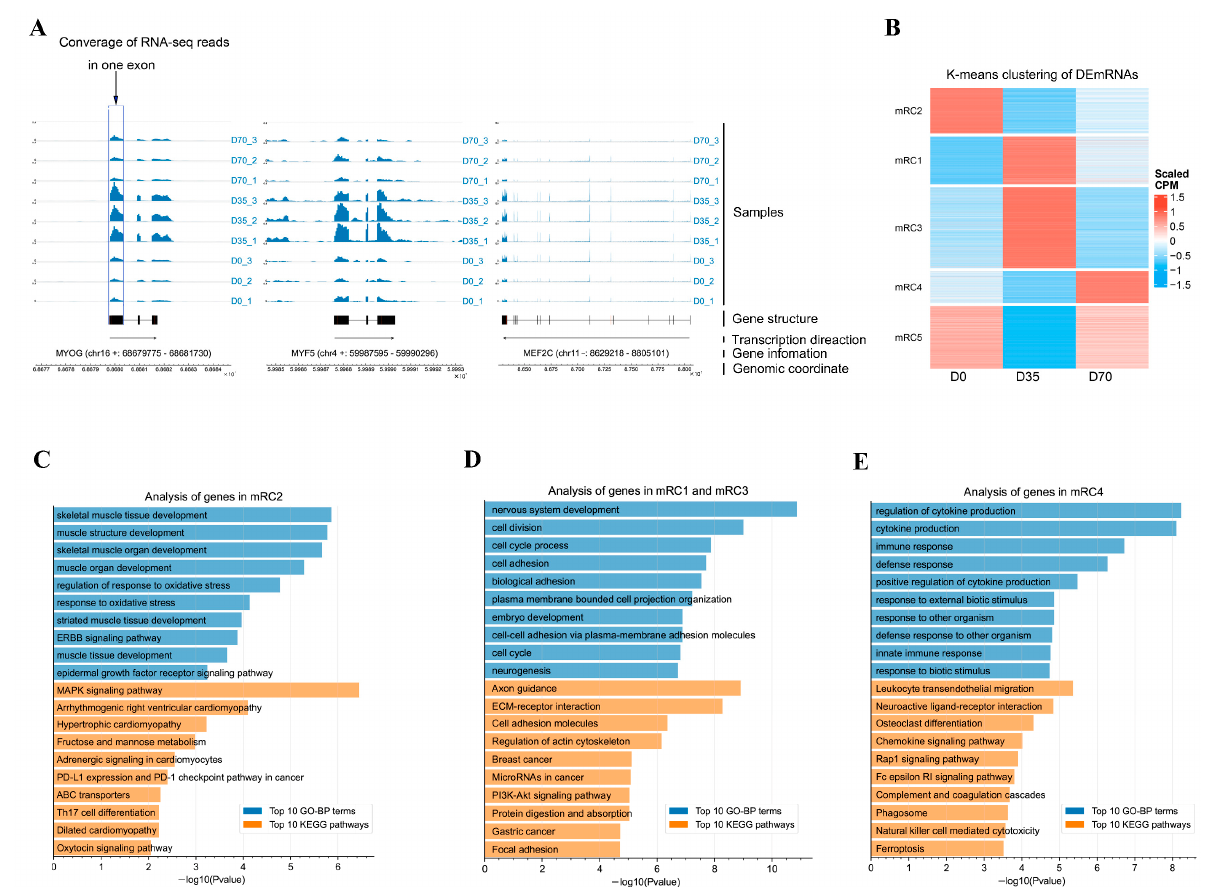
Figure 1. Dynamics of mRNA expression during development of skeletal muscle tissues at three growth stages in rabbits. ( A ) The RNA-seq tracks of all samples for the key genes ( MYOG , MYF5 , and MEF2C ) of skeletal muscle development. Each track shows one sample. The blue signals represent the coverage of RNA-seq reads. The genomic regions are shown, and the selected genes are highlighted in black. The gene information was marked by ‘gene name (chromosome strand: start–end)’. The black arrows indicate the transcription directions. ( B ) K-means clustering analysis of differentially expressed mRNAs. The mRC1–mRC5 show the five sorted groups by K-means clustering. ( C ) GO enrichment and KEGG pathway analysis of mRNAs in mRC2. The top 10 significantly enriched GO-BP terms and top 10 significantly enriched KEGG pathways were shown. ( D ) GO enrichment and KEGG pathway analysis of mRNAs in mRC1 and mRC3. The top 10 significantly enriched GO-BP terms and top 10 significantly enriched KEGG pathways were shown. ( E ) GO enrichment and KEGG pathway analysis of mRNAs in mRC4. The top 10 significantly enriched GO-BP terms and top 10 significantly enriched KEGG pathways were shown.